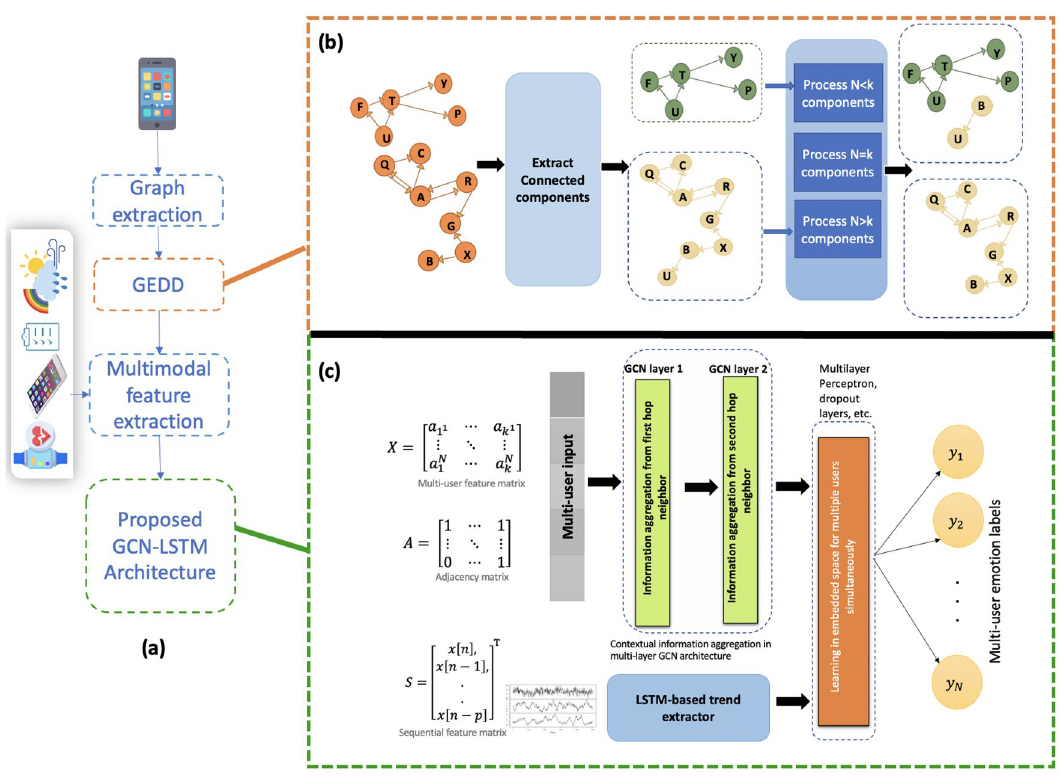
Figure 1. Graph-based Emotion Recognition with Integrated Dynamic Social Network architecture overview ( a ) Multi-user Graph-based learning flow diagram ( b ) Graph Extraction for Dynamic Distribution (GEDD) converts varying size graphs to the desired size with minimal loss of information ( c ) Graphical structure is integrated with temporal sensor data in the proposed Graph convolutional network-long-short term neural network (GCN-LSTM) architecture. The figure was drawn by the corresponding author in Microsoft PowerPoint, version 16.70 available at https:// www. micro soft. com/ en- us/ micro soft- 365/ power